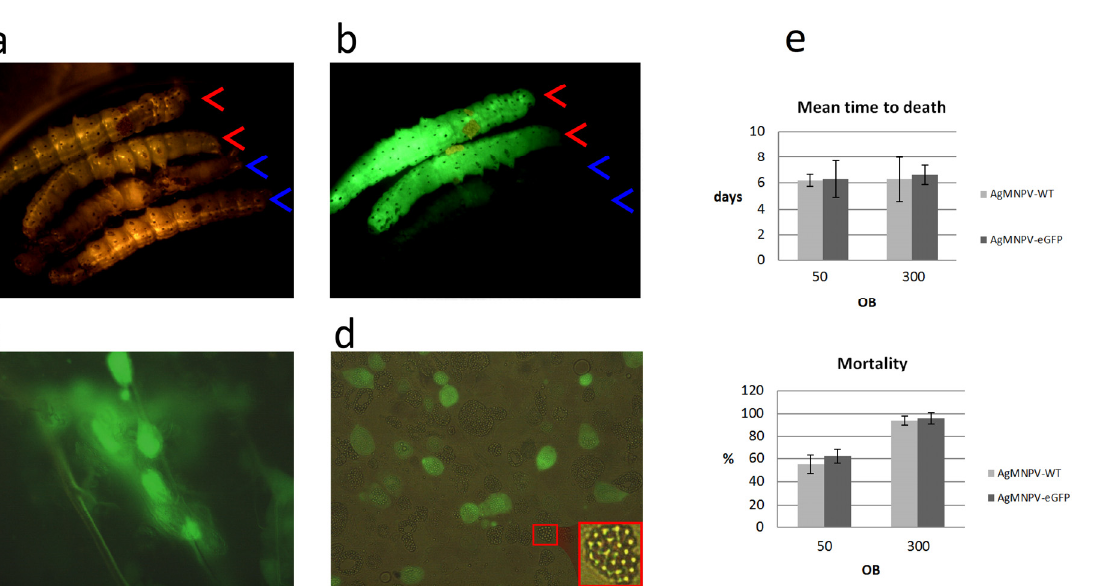
Figure 5. A. gemmatalis larvae orally infected with AgMNPV-GFP OBs (red arrowheads) and wt AgMNPV OBs (blue arrowheads) exposed to visible light ( a ) and UV light ( b ); tracheolar ( c ) and hemolymph ( d ) cells extracted from A. gemmatalis larvae infected with AgMNPV-GFP OBs. In the inset panel, polyhedra inside the nucleus of an infected cell are highlighted. ( e ) Results of mean time to death and mortality of A. gemmatalis larvae infected with recombinant AgMNPV-GFP and wt AgMNPV ( n = 20 per treatment). The larvae consumed 50 (1 LD 50 ) and 300 OBs (6 LD 50 ) in parallel